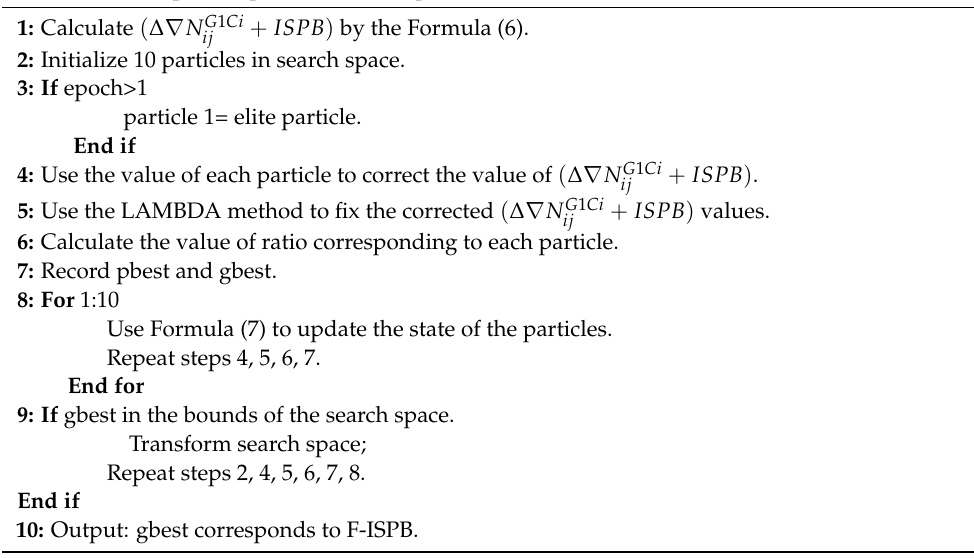
Algorithm 2 improved particle swarm optimization to estimate